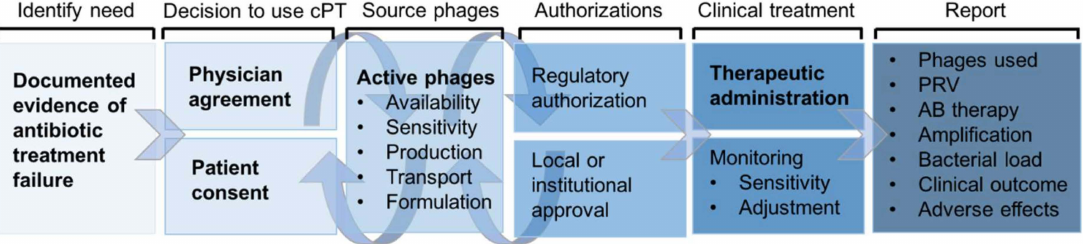
Figure 1. General process and considerations for compassionate phage therapy (cPT). Required steps are shown in bold. Circular arrows indicate processes that are dynamic and do not occur necessarily in a chronological order. PRV: Phage-resistant variant. AB: